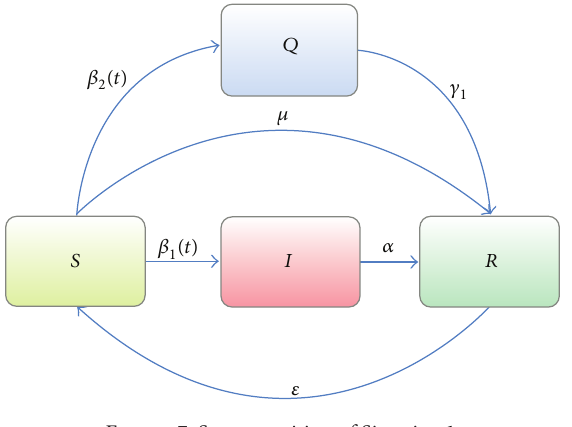
Figure 7: State transition of Situation 1.